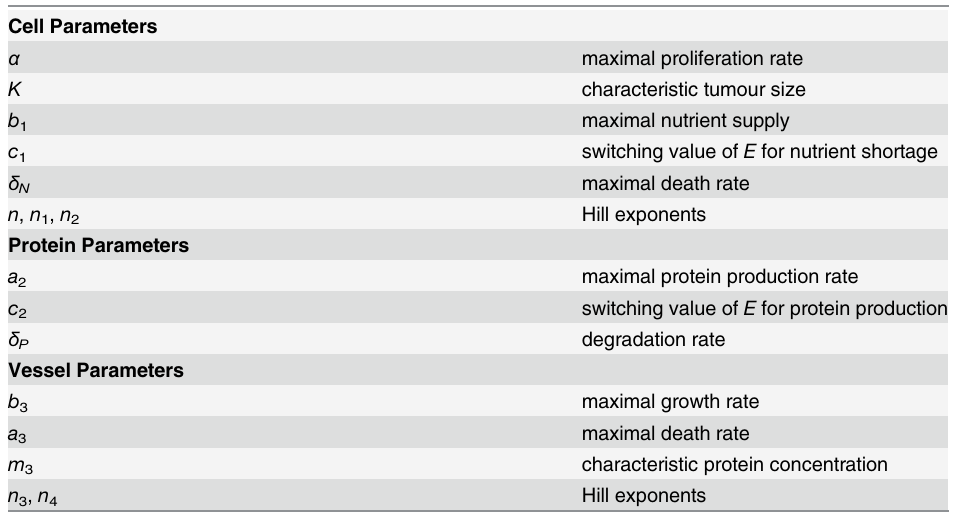
Table 1. Microscopic